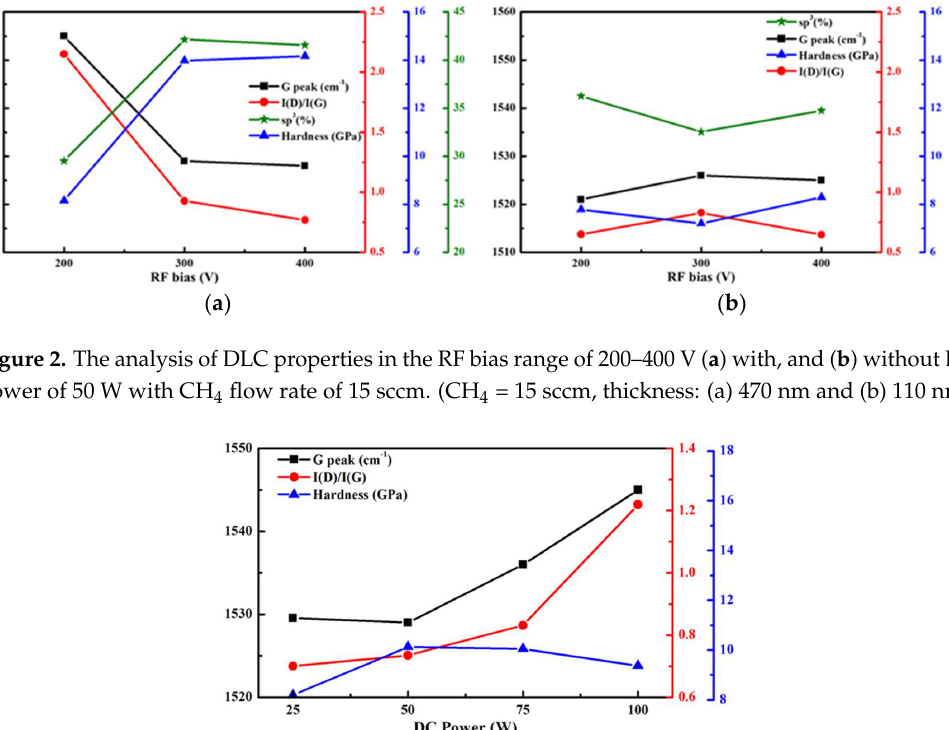
Figure 3. The analysis of DLC properties in the DC power range of 25–100 W with RF bias of 400 V. (CH 4 = 15 sccm, Thickness = 150 ± 10 nm).